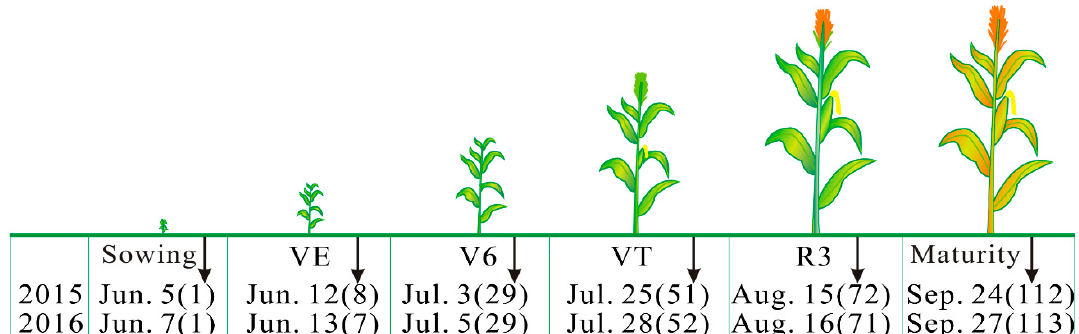
Figure 3. Seasonal schedule of crop growth stages of summer maize (VE, emergence; V(n), (n)-leaf stage; VT, tasseling stage; R3, milk stage) at the Xuchang Irrigation Experiment Station. The date in the figure was recorded when more than three quarters (>75%) of the crops developed into the particular growth stage. The number in parentheses is days after sowing.